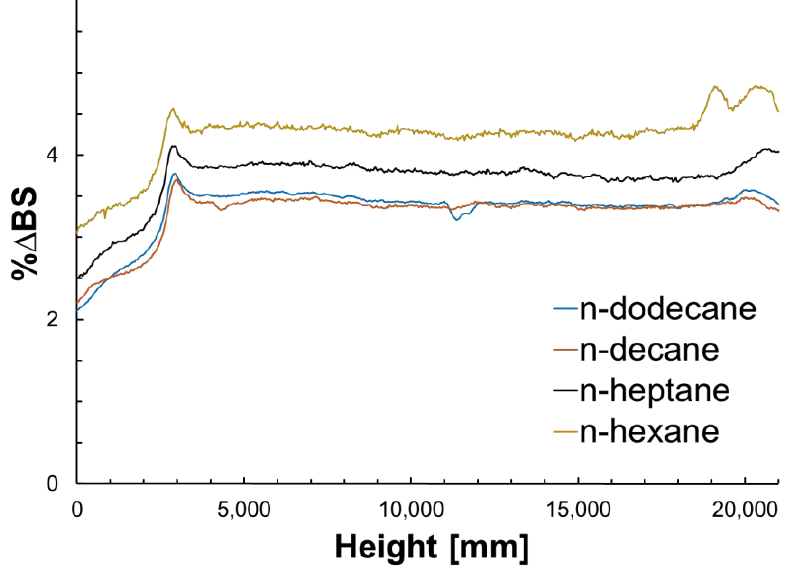
Figure 2. % ∆ BS signal as a function of the height of the sample from 0 to t 1 for all n-alkanes. Figure 2. %∆BS signal as a function of the height of the sample from 0 to 𝑡 1 for all n-alkanes.